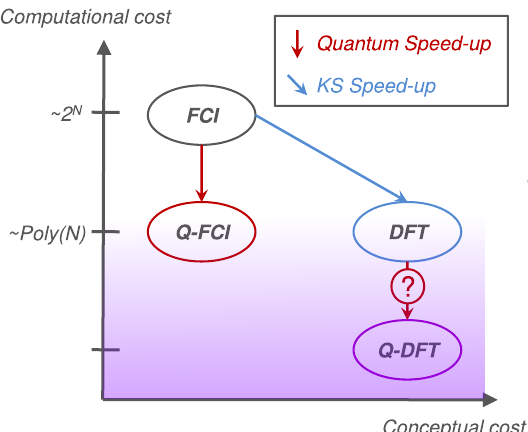
Figure 1: Computational cost to extract the ground-state energy for full configuration interaction (FCI) and DFT, with or without the use of quantum computers. Q-FCI and Q-DFT refer to the analog of FCI and DFT on quantum computers,